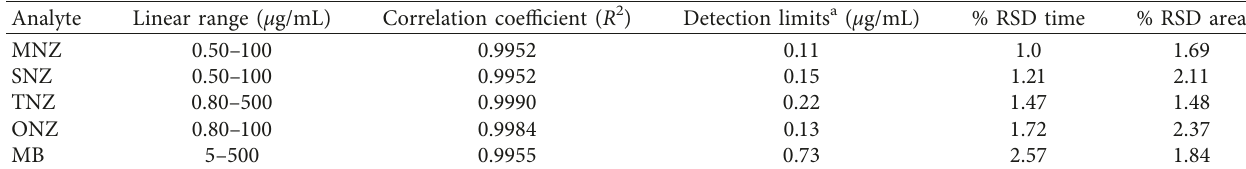
Figure 5: Effect of the applied voltage on separation of 5-nitroimidazole compounds. Electrochromatographic conditions: pH 4.82 and applied voltage 0 kV, +5kV, +10kV, +15kV, and +20kV. Other conditions and the order of peak can be seen in Figure Table 1: Linear range, detection limit, and precisions.